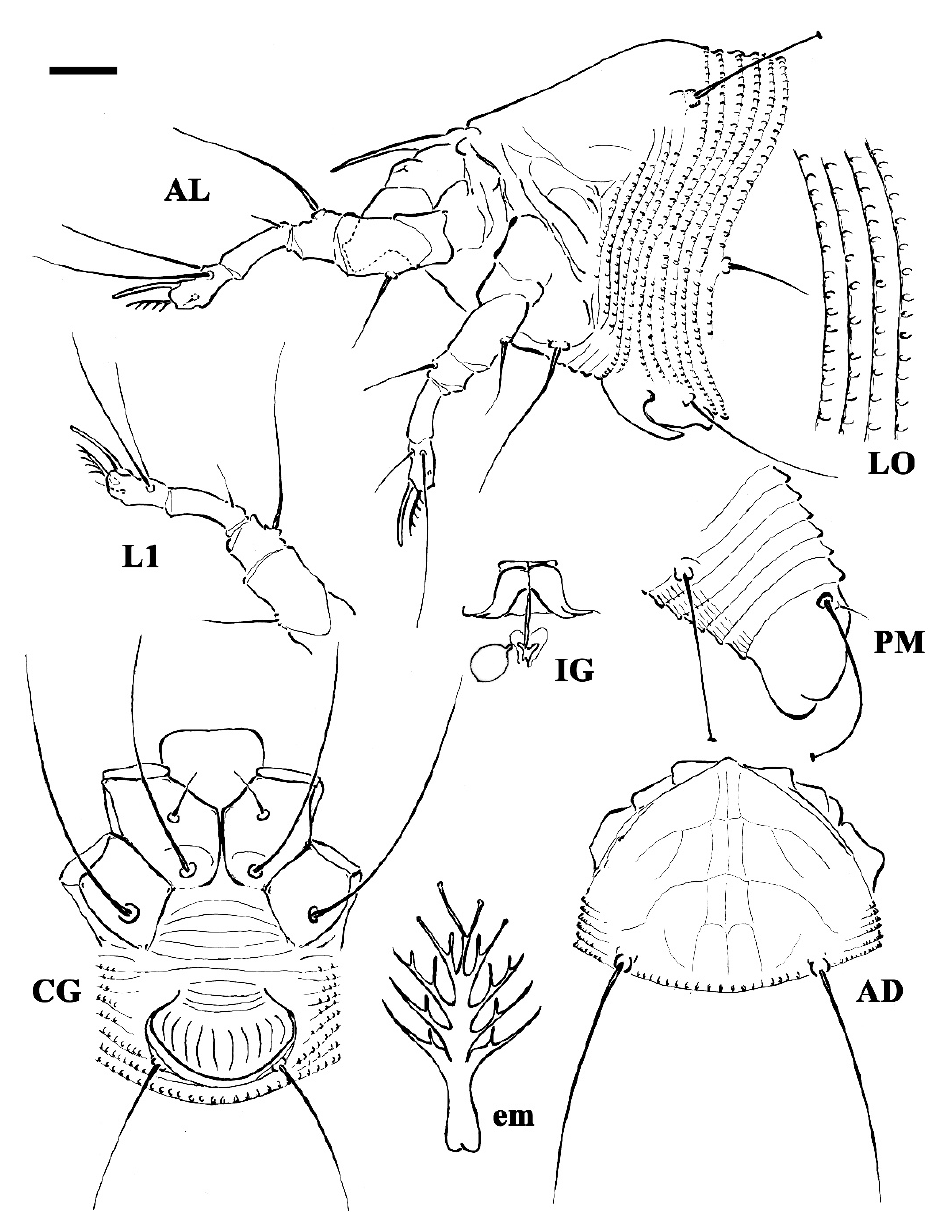
Figure 1. Line drawings of a deutogyne of Aculus mosoniensis . AD: prodorsal shield; AL: lateral view of anterior body region; CG: female coxigenital region; em: empodium; IG: internal female genitalia; LO: lateral view of annuli; L1: leg I; PM: lateral view of posterior opisthosoma. Scale bar: 10 μ m for AD, AL, CG, IG, and PM; 5 μ m for LO and L1; 2.5 μ m for em.